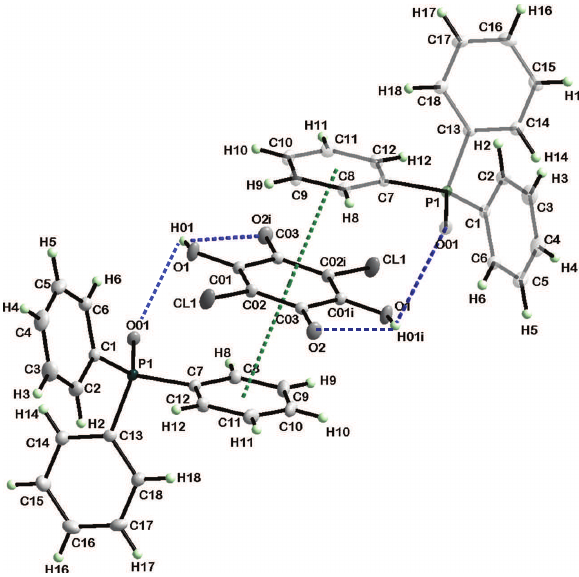
Table 1: Data collection and